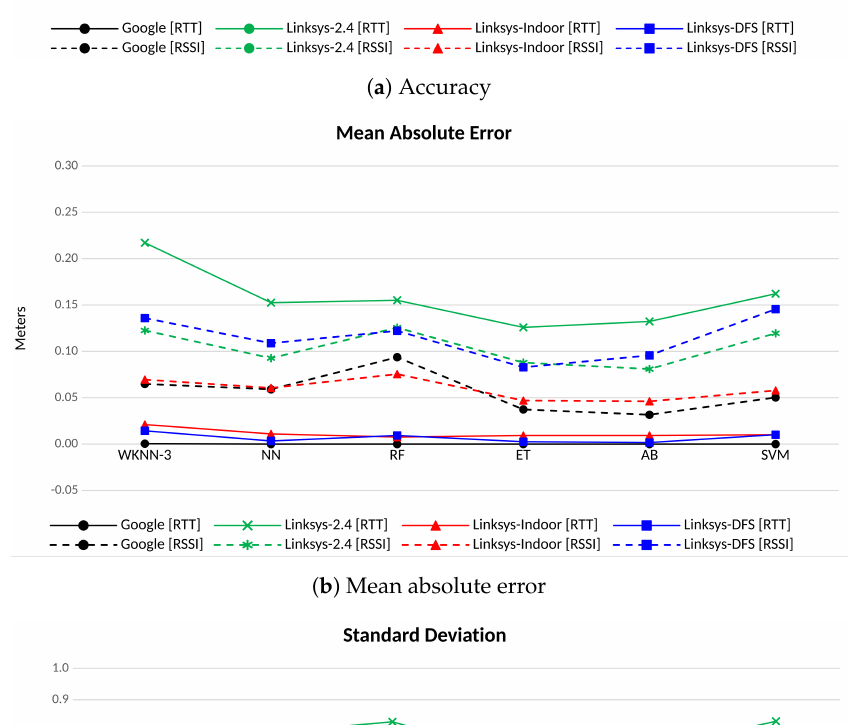
Figure 10. Accuracy, mean absolute error and standard deviation for different ML algorithms, APs vendor and channel. FTM-based in solid lines, RSS-based in dashed